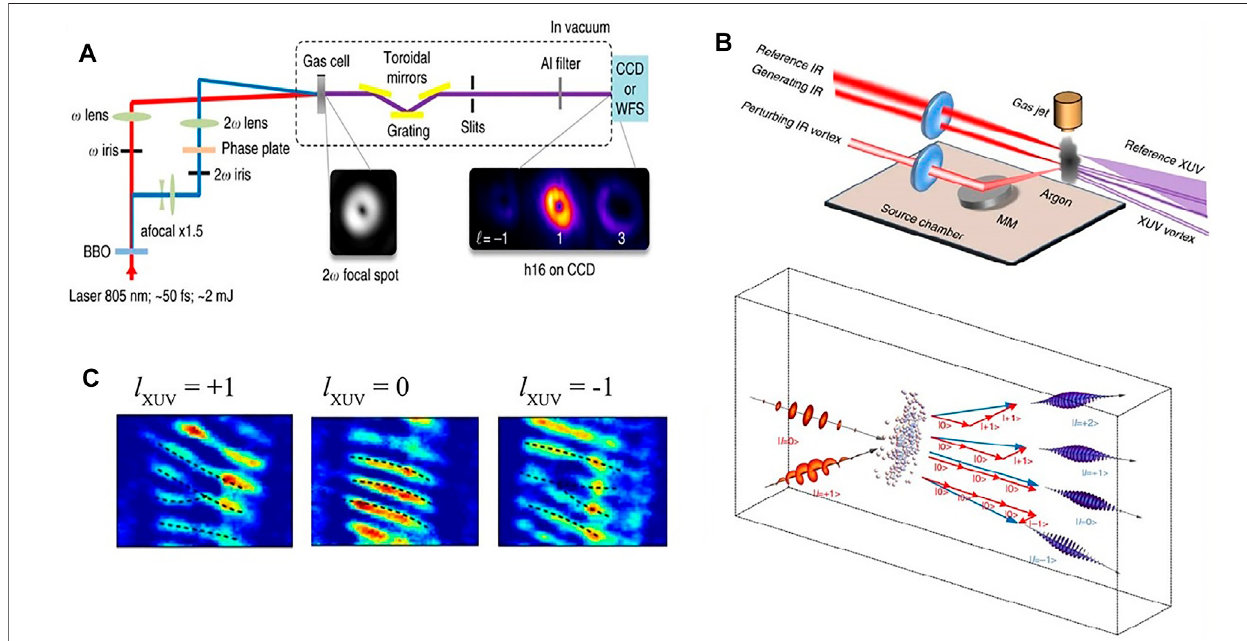
FIGURE5|(A) HHGforXUVwithtunableOAM[113] (B) HHGforextremebasedontheArgongasjet[114] (C) interferogramof (B) withaplane-waveasreference beam, recorded in the CCD camera.